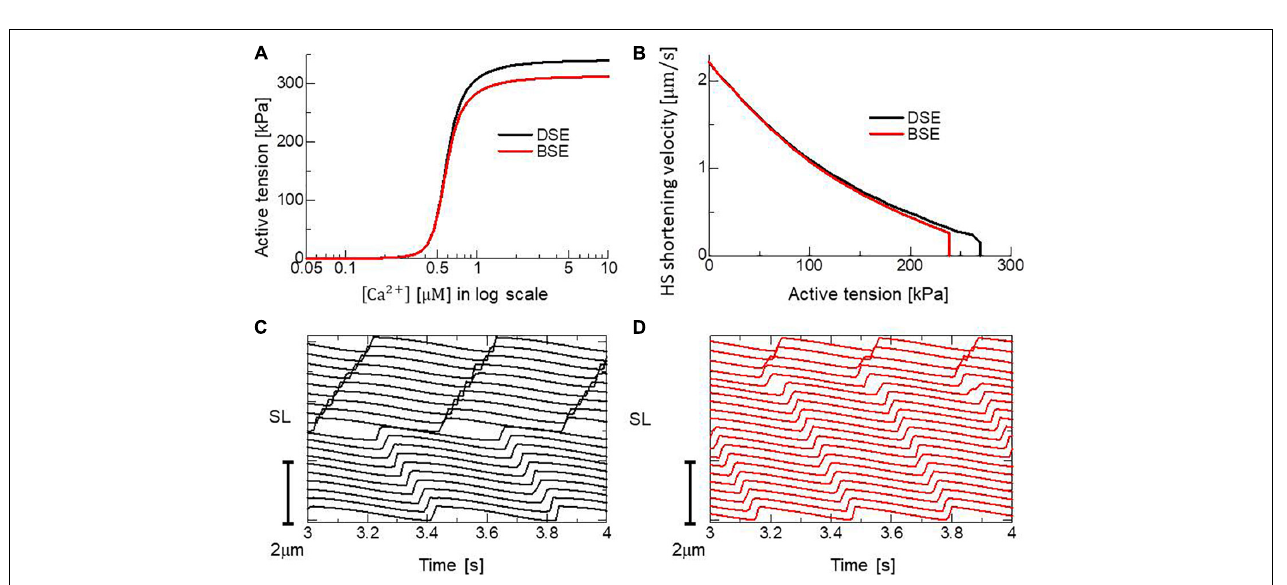
FIGURE 10 | Comparisons of the DSE and BSE models in (A) the force-pCa relationship under the unloaded sarcomere length, (B) the force-velocity relationship at [Ca 2 + ] = 0.7 µ M. Both the (C) DSE and (D) BSE models reproduced the SPOC for 20 sarcomeres in a single myofibril under the constant Ca 2 + concentration ([Ca 2 + ] = 0.3 µ